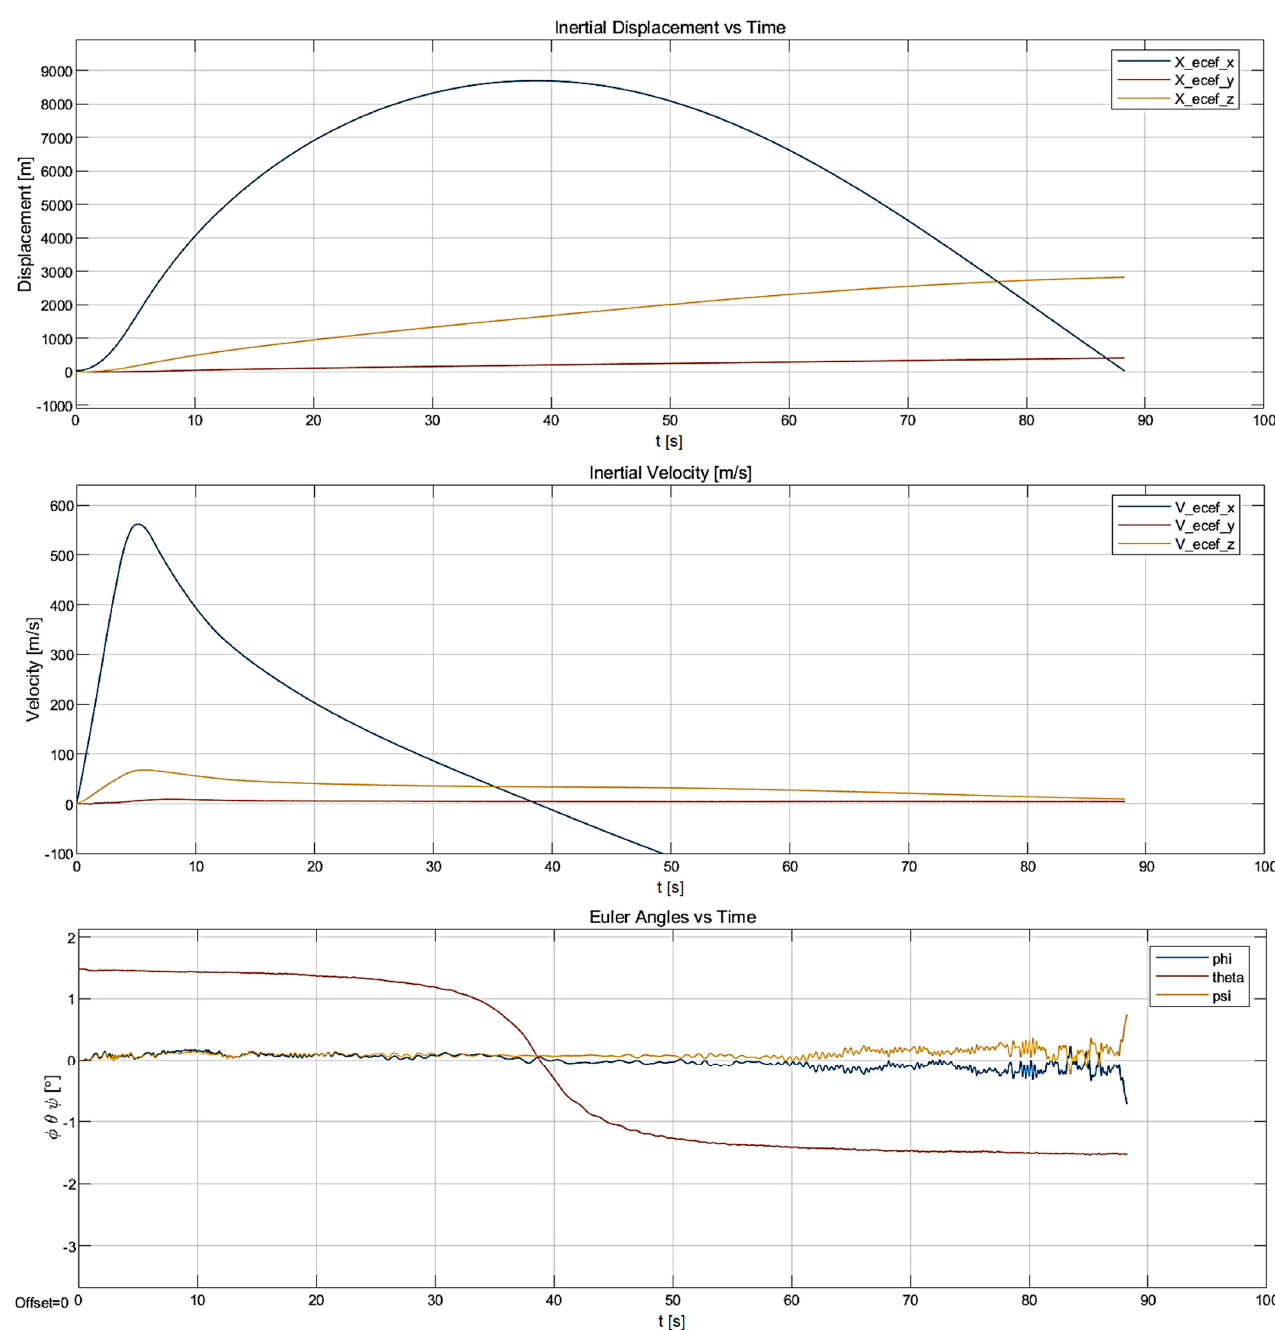
Figure 22. Inertial axis